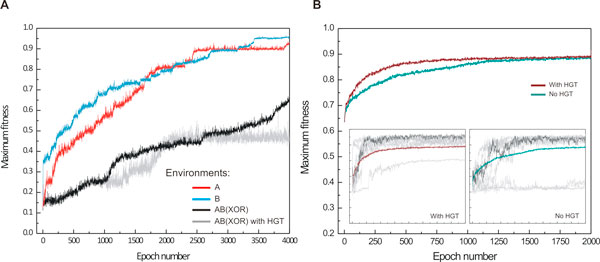
Fitness trajectories in partial A, B, and full AB (XOR) environments. (A) Evolution of random populations of cells in A, B and XOR environments shown in red, blue, and black respectively. Grey curve shows the averaged fitness trajectory for evolution in a XOR environment with the presence of HGT. Maximum fitness is averaged over 64 simulations for evolution in A and B environments, and over 32 simulations for evolution in a XOR environment. HGT rate here is at 5·10-5 and average fragment size is 4 triplets. (B) Evolutionary trajectory under "dual-step" evolution, where population of evolved cells in A and B environments show remarkably fast adaptation to environment AB (64 simulations). HGT confers an additional acceleration of adaptation to new settings. (B, inserts) Maximum fitness curves for 8 out of 64 individual simulations with (B, left insert) and without (B, left insert) HGT are shown in grey. One curve is highlighted with dark grey for clarity.